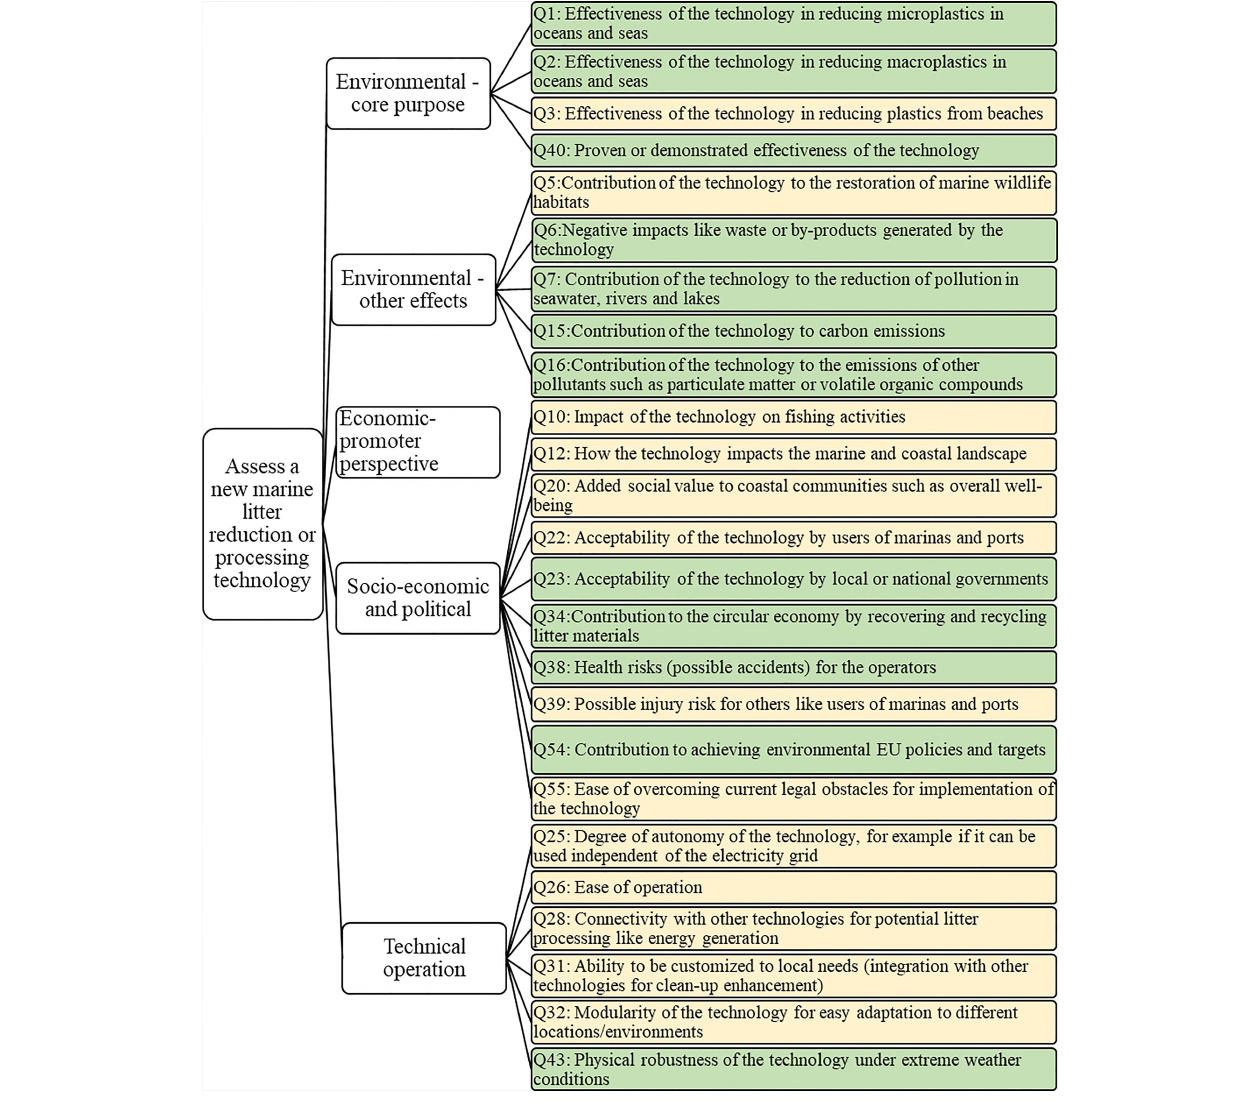
FIGURE 14 | Key (darker) and advisable (lighter) aspects selected according to the groups of